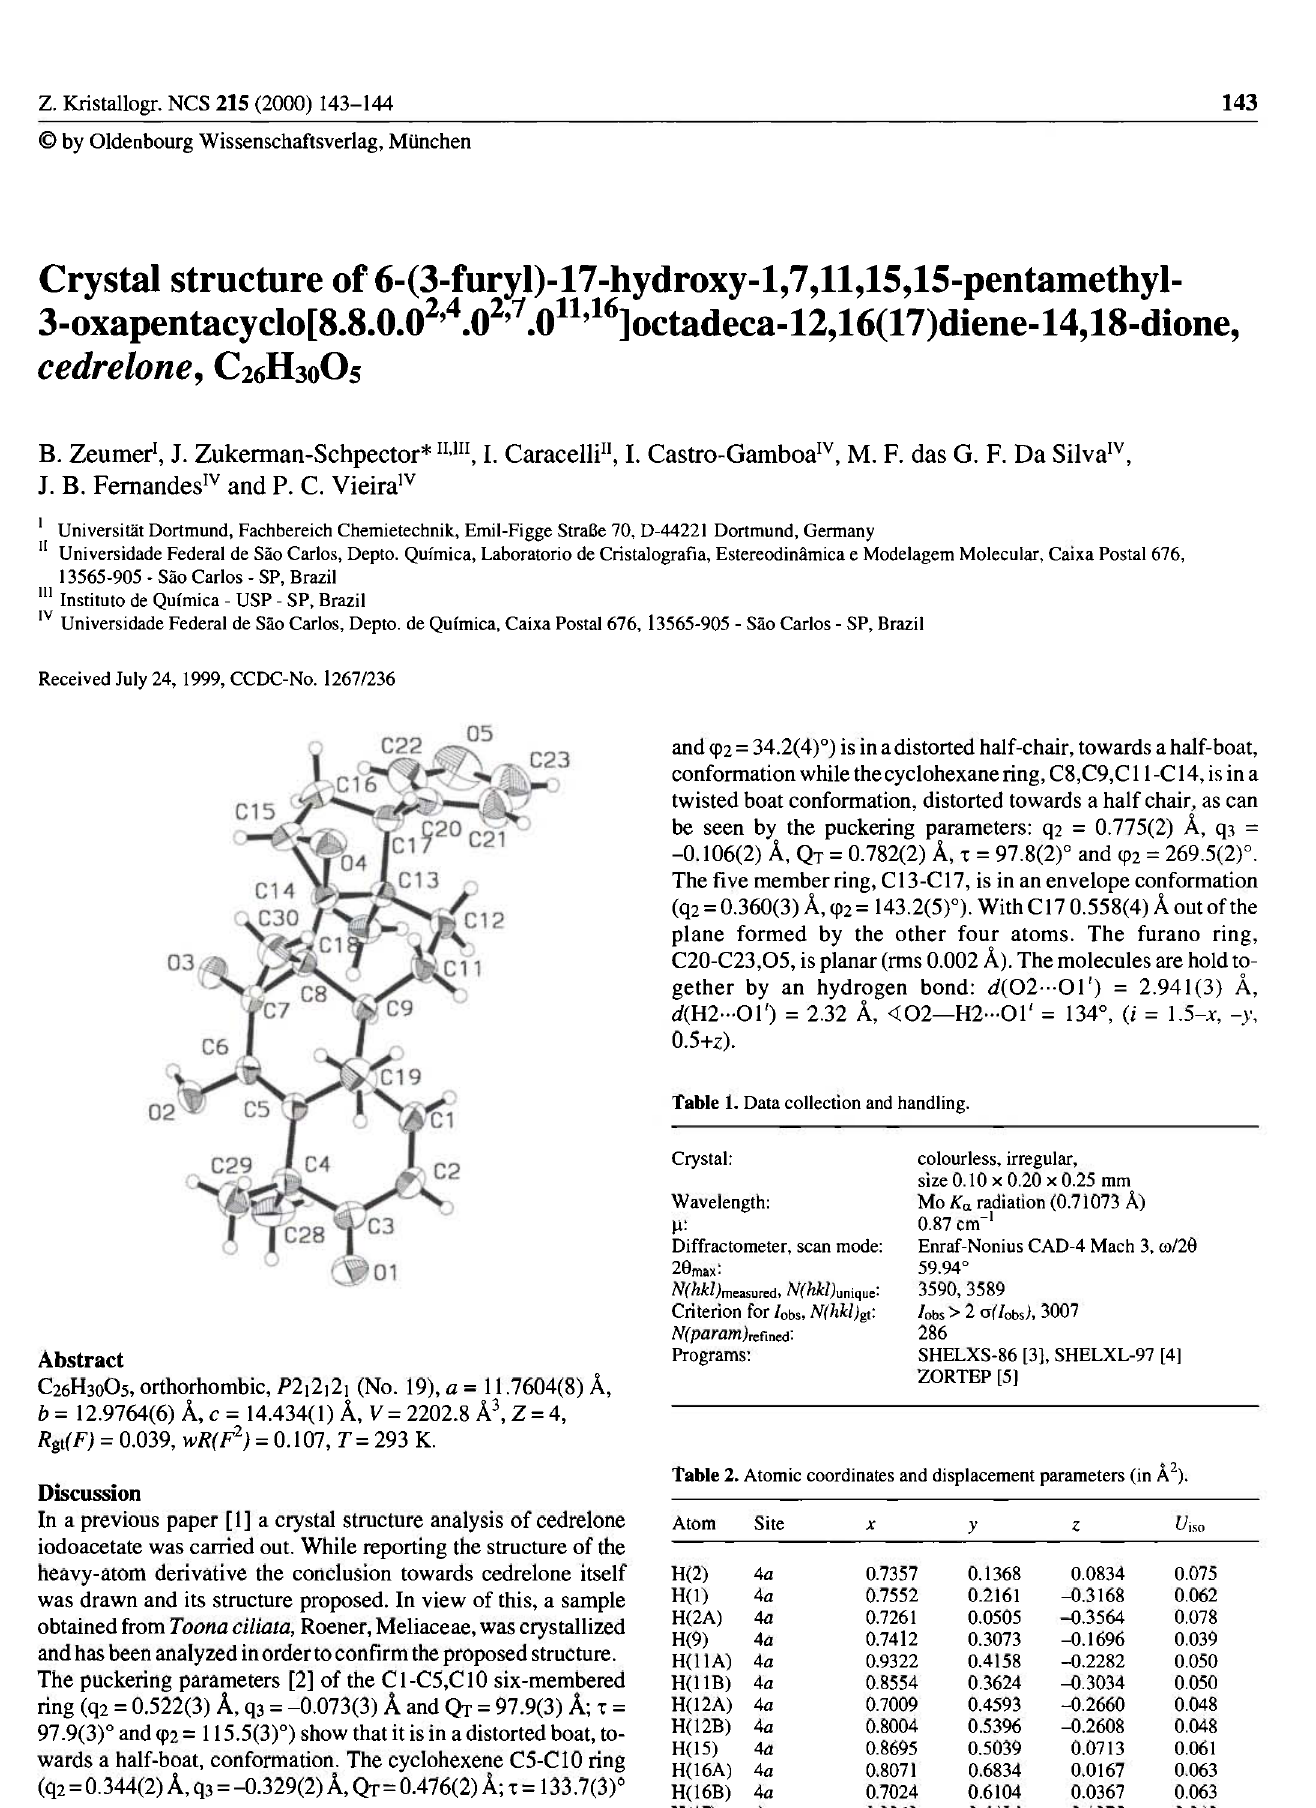
Table 2. Atomic coordinates and displacement parameters (in A 2